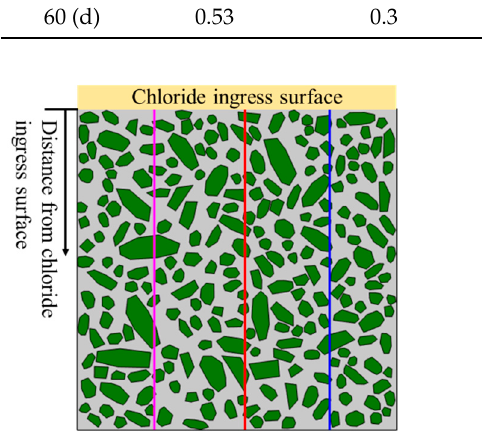
Figure 4. Schematic diagram of distance from chloride ingress surface.